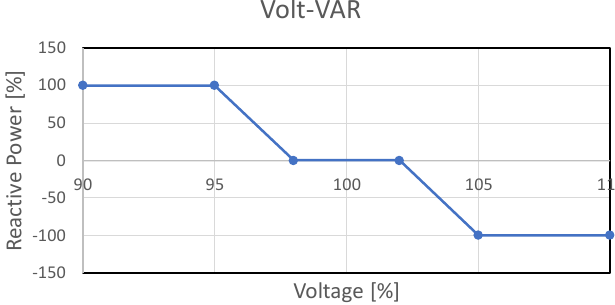
Figure 10. Volt-VAR curve used in this study (inverter default factory curve).